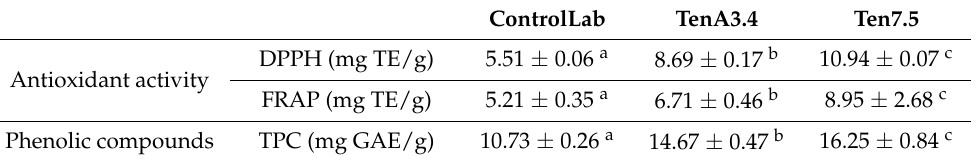
Table 5. Phenolic composition and antioxidant activity of formulations with the incorporation of different proportions of T. molitor flour (3.4% and 7.5%) and comparison with control samples (0%). The results of the DPPH (diphenyl-1-picrylhydrazyl radical) and FRAP (ferric reducing antioxidant power) analyses are expressed in mg Trolox equivalents (TE)/g. The results of the TPC analysis (total phenol content) are expressed in mg gallic acid equivalents (GAE)/g. Means with different letters in the same row are significantly different (Tukey test. p <